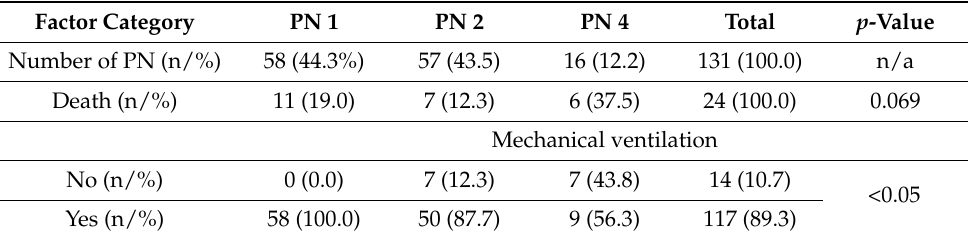
Table 3. Analysis of PN considering the type of microbiological diagnostics and mechanical ventila- tion, mortality in ICU in